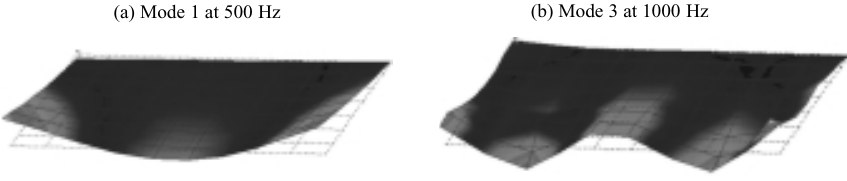
Fig. 6. Mode 1 (a) and 3 (b) of the work piece table of the milling